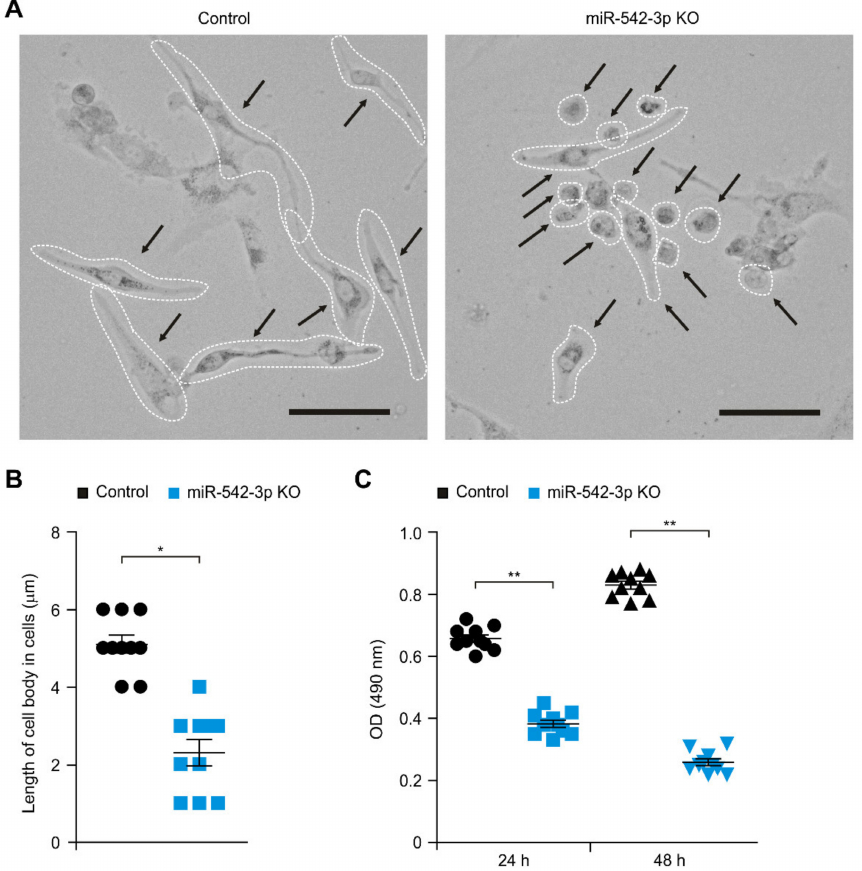
Figure 1. The knockdown of miR-542-3p suppresses cellular proliferation in human glioma cells. ( A ) Representative cellular morphology images and ( B ) quantification of lengths of cell bodies of control (Control) and miR-542-3p knockdown (miR-542-3p KO) human glioma U87MG cells. ( n = 10 images per individual subject, n = 3 per group). Scale bars, 20 µ m. Data are representative from three independent experiments. Data are mean ± SD. * p < 0.05 by the two-tailed Student’s t -test. ( C ) Cell proliferation assay in control (Control) and miR-542-3p knockdown (miR-542-3p KO) human glioma U87MG cells. ( n = 10 images per individual subject, n = 3 per group). Data are mean ± SD. ** p < 0.01 by the two-tailed Student’s t